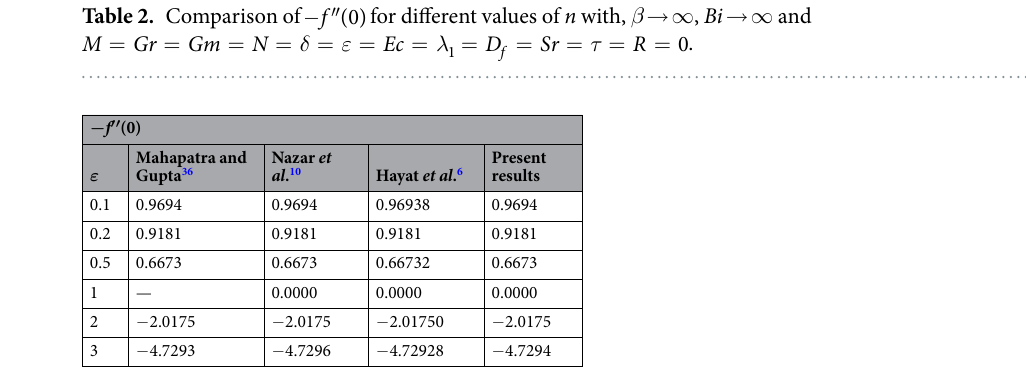
Table 3. Comparison of − ″ f (0) for different values of ε with, n = 1, β → ∞ , Bi → ∞ and